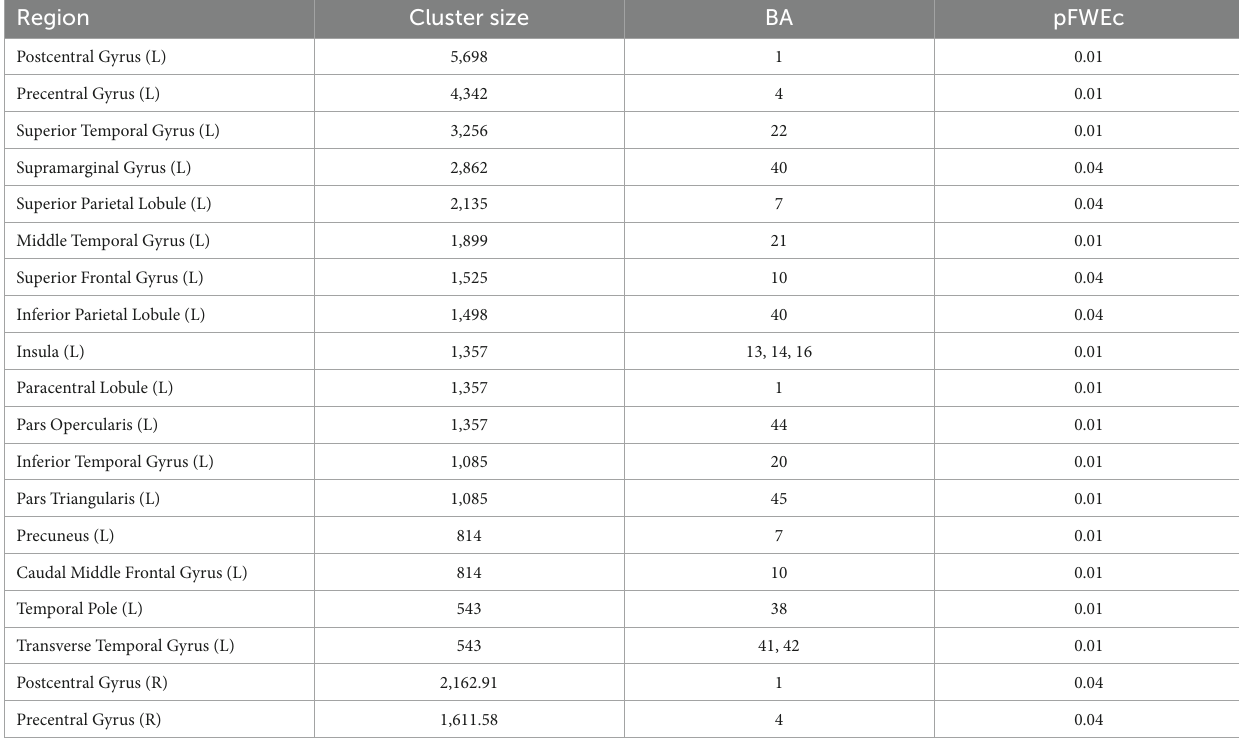
TABLE 3 Clusters of differential brain structure between